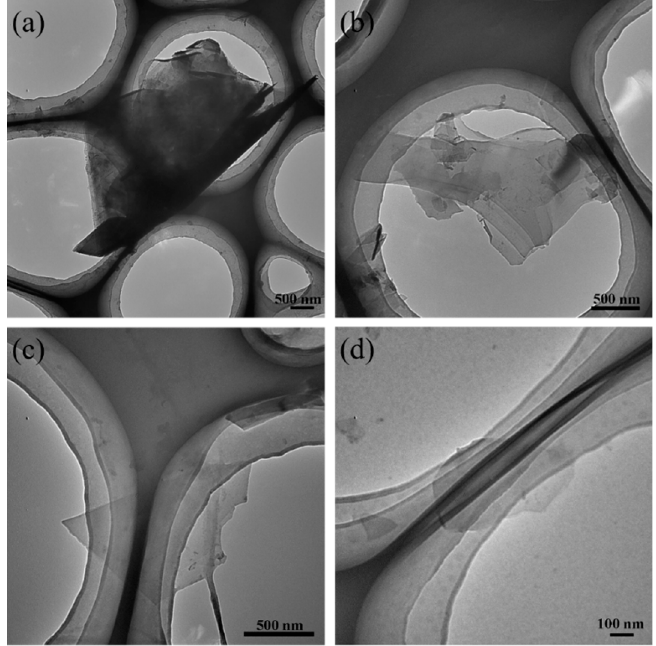
Figure 4. Transmission electron microscopy (TEM) micrographs of the graphene prepared using 5 ( a ), 10 ( b ), 20 ( c ), and 30 ( d ) microfluidization cycles.